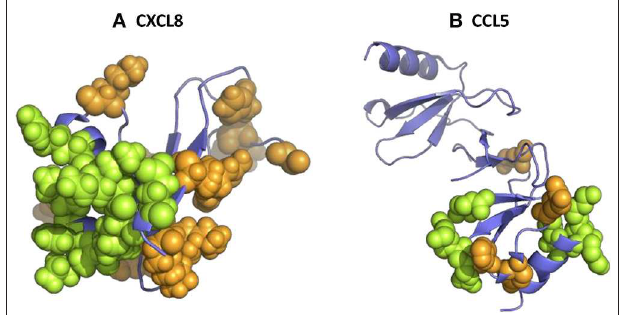
FIGURE 2 | The 3D structure of human CXCL8 and CCL5 and their glycosaminoglycan (GAG)-binding amino acids. 3D models of human CXCL8 (A) and CCL5 (B) were drawn from PDB accession codes 4XDX and 5COY, respectively, to visualize the location of the amino acids which were shown to be important for GAG binding (green). In addition, other basic amino acids are visualized in